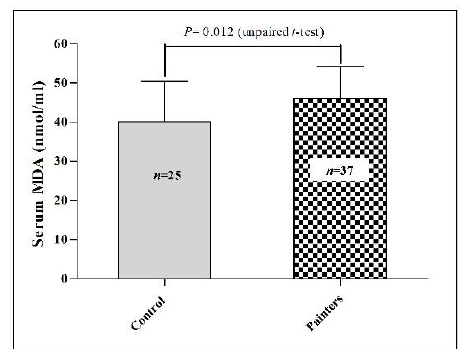
Figure (6): Serum malondialdehyde (MDA) levels of painting workers in Sulaimani city. n : number of subjects; P <0.05: significant difference compared with control